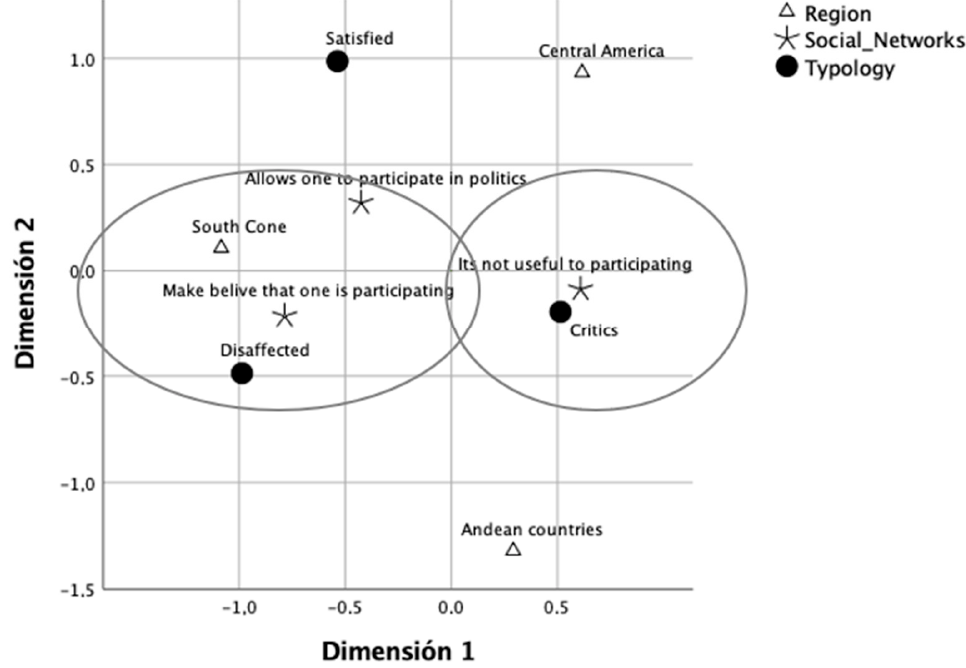
Figure 5. Profiles of disaffection by region and perception of political information on social networks. Source: Latinobarometer 2020.